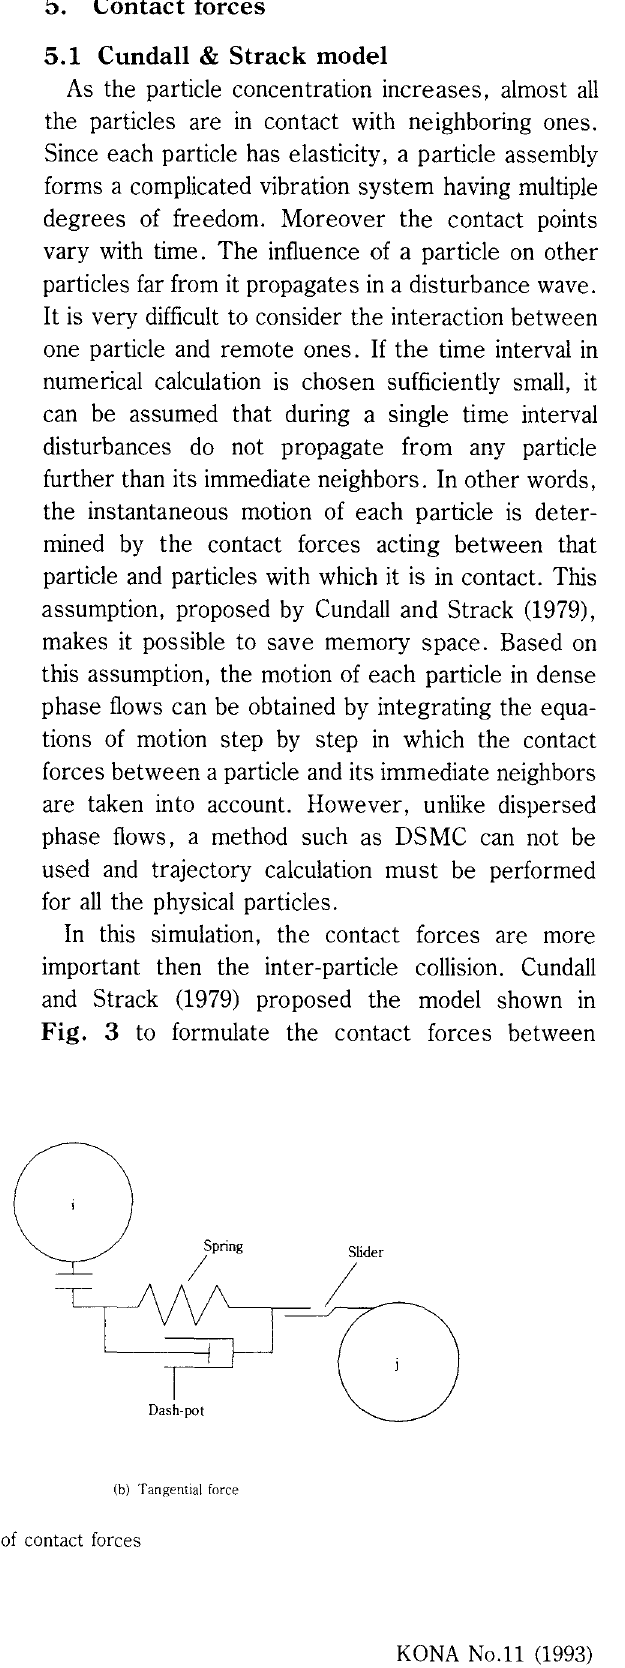
Fig. 3 Model of contact